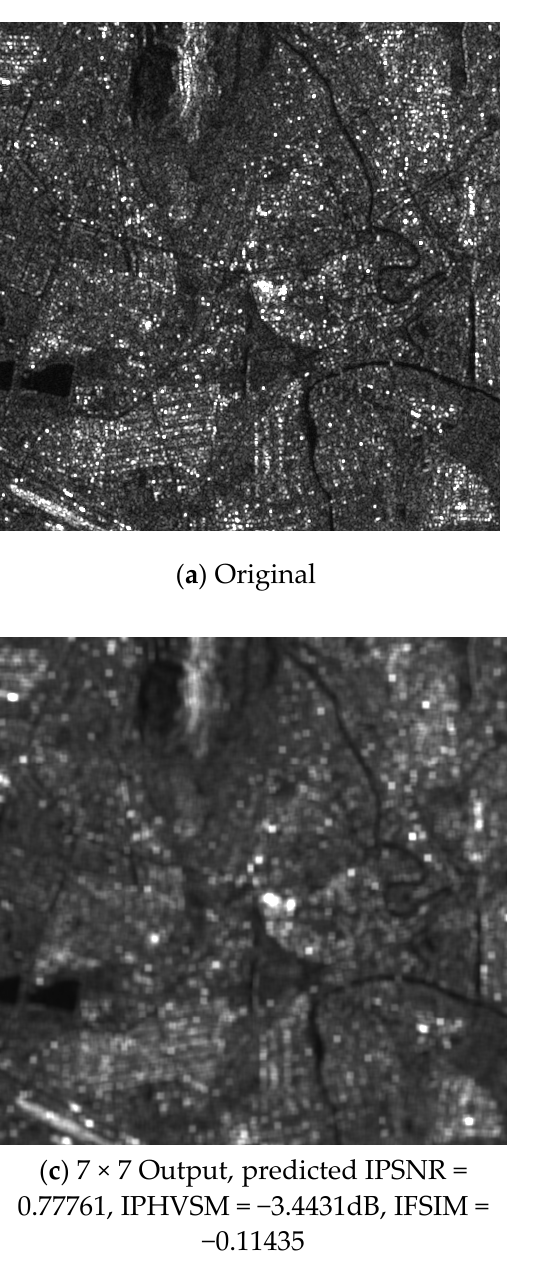
Figure 21. The original Sentinel-1 image ( a ); and the outputs of the 5 × 5 ( b ); 7 × 7 (c); and 11 × 11 ( d ) Lee filters. Finally, Figure 22 shows an image with large homogeneous regions. According to IPSNR and IFSIM, the 11 × 11 window is the best, but according to IPHVSM, the 7 × 7 pixel window is better. We prefer to agree with the latter